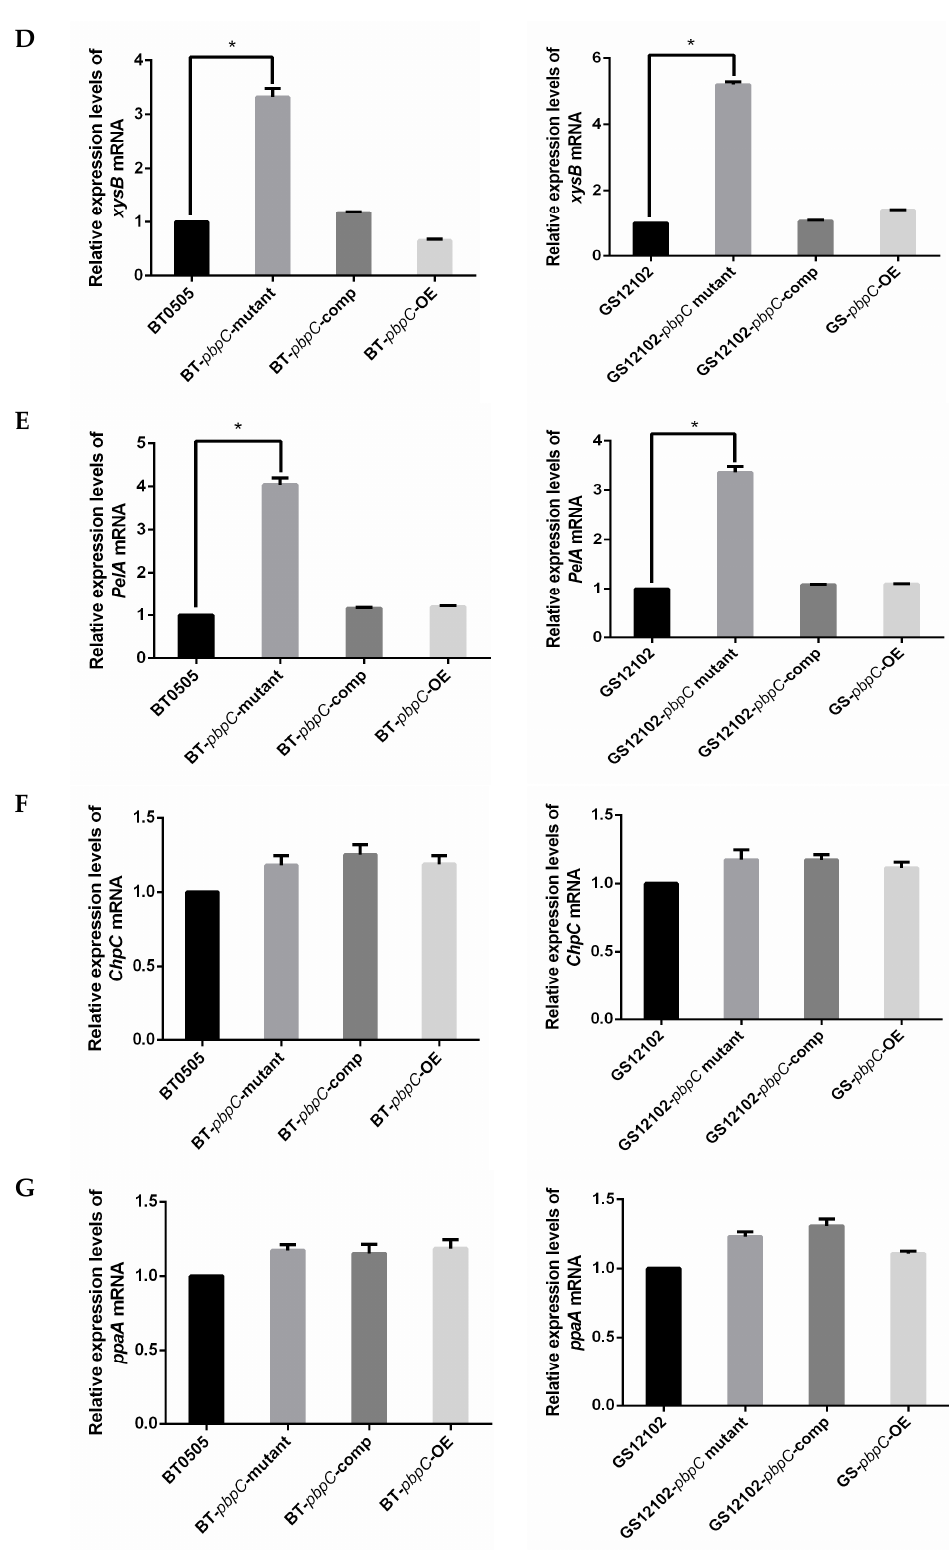
Figure 1. Relative expression levels of ( A ) CelA , ( B ) CelB , ( C ) xysA , ( D ) xysB , ( E ) pelA ( F ) ChpC , and ( G ) ppaA determined by quantitative reverse-transcription polymerase chain reaction (qRT-PCR) for BT0505 and GS12102, the △ pbpC mutants, pbpC -comp, and pbpC -OE strains compared with their wild-type strains. Relative gene expressions were normalized by gyrB , gapA , and bipA , which we employed as housekeeping references. Results are presented as means of three independent experiments with standard deviation (n = 3). Asterisks (*) indicate significant differences ( p < 0.05).